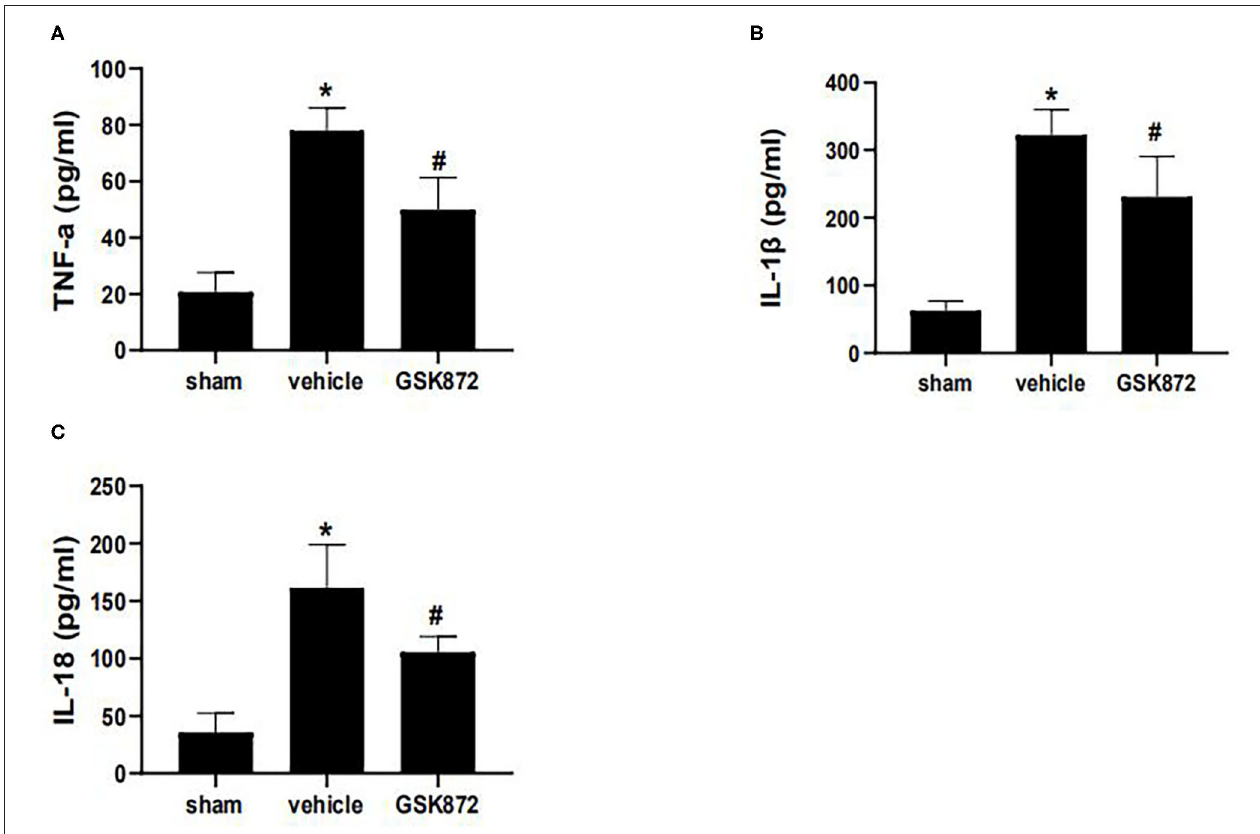
FIGURE 4 | Intrathecal injection of GSK872 (10 µ l, 25 mmol/L) inhibited neuroinflammation in the lumbar spinal dorsal horns ( n = 4 for each group). (A–C) The levels of TNF- α , IL-1 β , and IL-18 in different groups, including sham, vehicle and GSK872 group, were investigated by ELISA. The protein level of TNF- α , IL-1 β , and IL-18 were reduced after GSK872 treatment. All data were calculated as mean ± SD. * p < 0.05 vs. the sham group. # p < 0.05 vs. the vehicle group. Comparisons between multiple groups were carried out by one-way ANOVA and Turkey’s post-hoc analysis. IL, interleukin; TNF- α , tumor necrosis factor- α